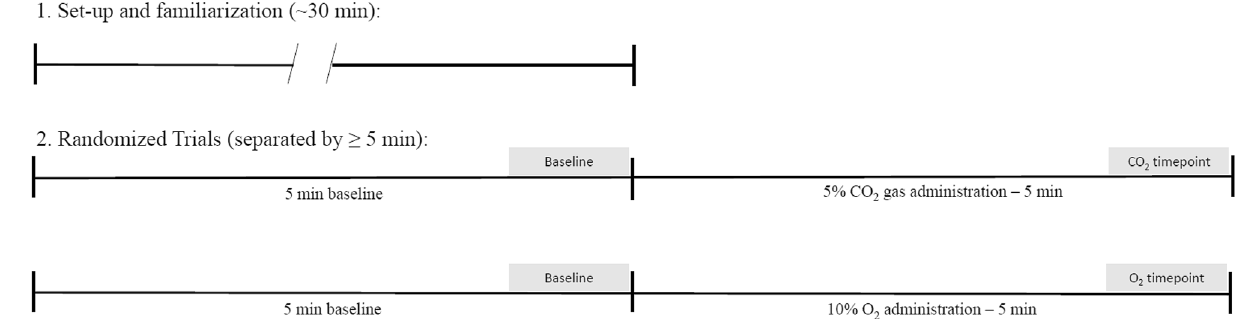
Figure 1. Depiction of protocol completed before and after completion of 4-h HDBR. Grey areas indicate where the data were used to calculate the Δ cardiorespiratory and cerebrovascular response to the respective gas